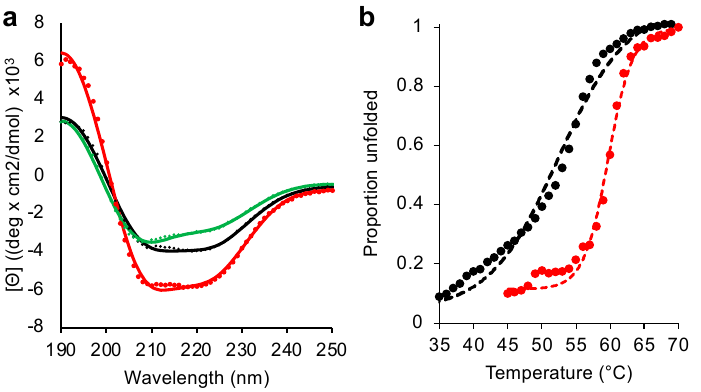
Figure 4. CD spectroscopy of EstN7. ( a ) CD spectra of EstN7 WT (black), EstN7 N211A (red) and EstN7 DM (green). CD spectra were collected at 20 ° C and a Savitzky–Golay filter applied. ( b ) Temperature-dependent change in proportion of protein folded (based on molar ellipticity at 222 nm at each temperature) for EstN7 WT (black) and EstN7 N211A (red). The dashed line represents the Boltzmann sigmoidal fit of the data (circles).